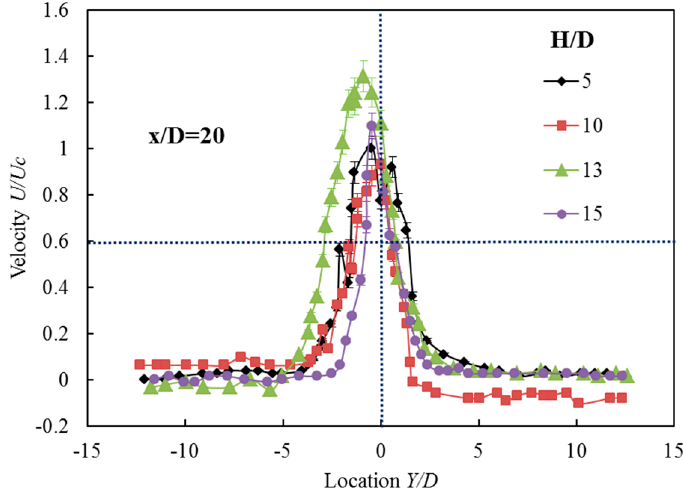
Figure 7. Axial mean velocity of the horizontal plane ( X - Y ).